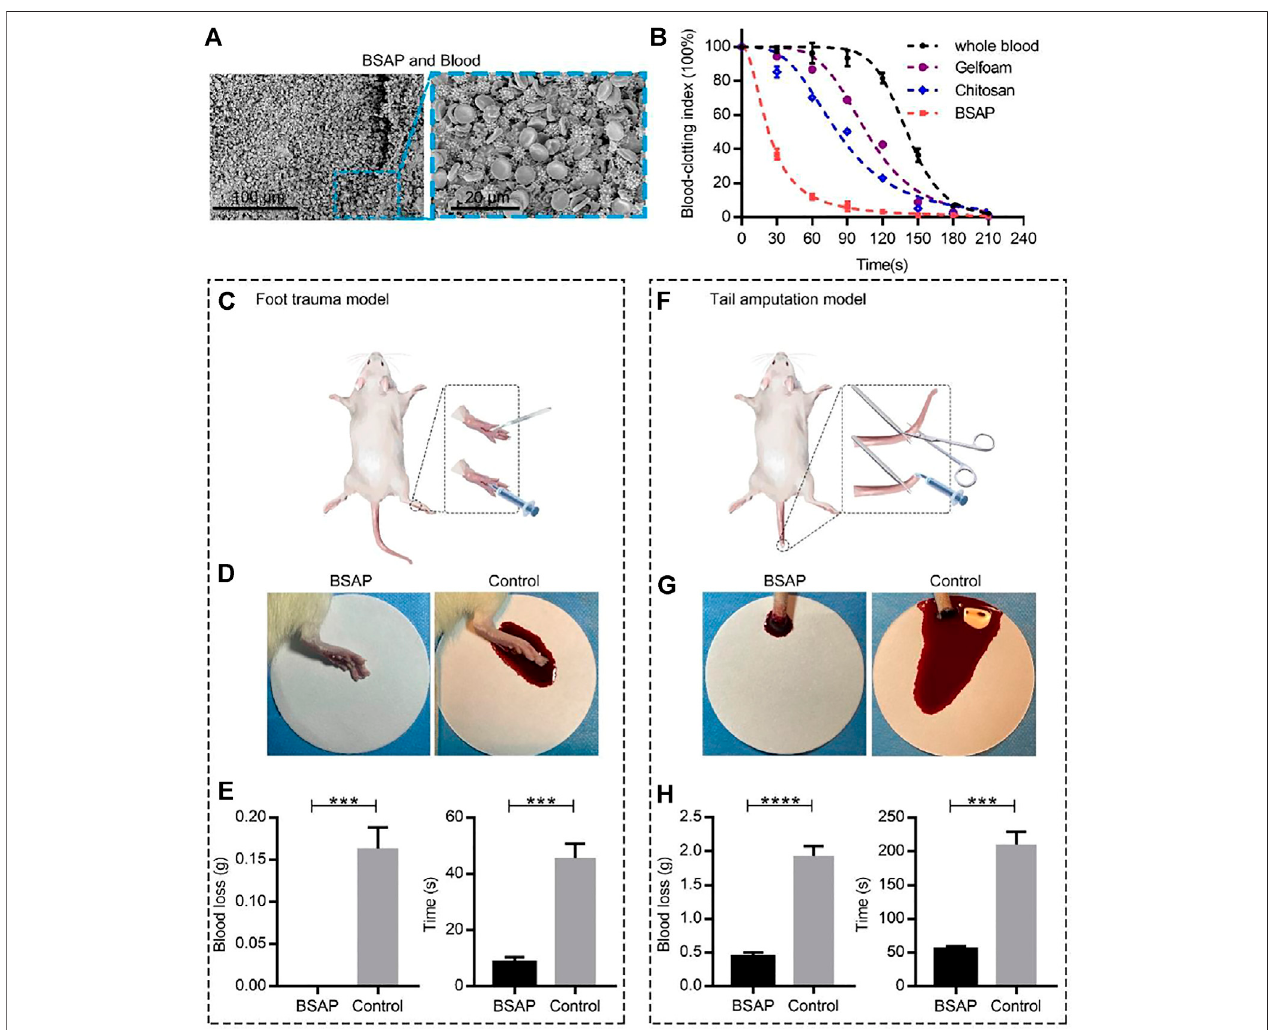
FIGURE 3 | Hemostatic performance ofBSAPhydrogel. (A) SEM ofthe blood clots of BSAP hydrogel integrated with whole blood. The erythrocyte and deformed plateletsaregatheredtoformacompactstructure. (B) Thebloodclottingindex(BCI)oftheBSAPhydrogelandcontrols(wholeblood,Gelfoam,Chitosan)basedontime ( n = 4). The blood solutions were measured at 600 nm. (C) Schematic illustration of the establishment of rat foot trauma model. (D) Bleeding photograph and (E) hemostatic ability (blood loss and hemostatic time) of BSAP hydrogel in rat foot trauma model ( n = 3, p P < 0.05, pp p < 0.01, ppp p < 0.001, pppp p < 0.001 ). (F) Schematic illustration of the establishment of rat tail amputation model. (G) Bleeding photograph and (H) hemostatic ability (blood loss and hemostatic time) of BSAP hydrogel in rat tail amputation model ( n = 3, p P < 0.05, pp p < 0.01, ppp p < 0.001, pppp p < 0.001 ).